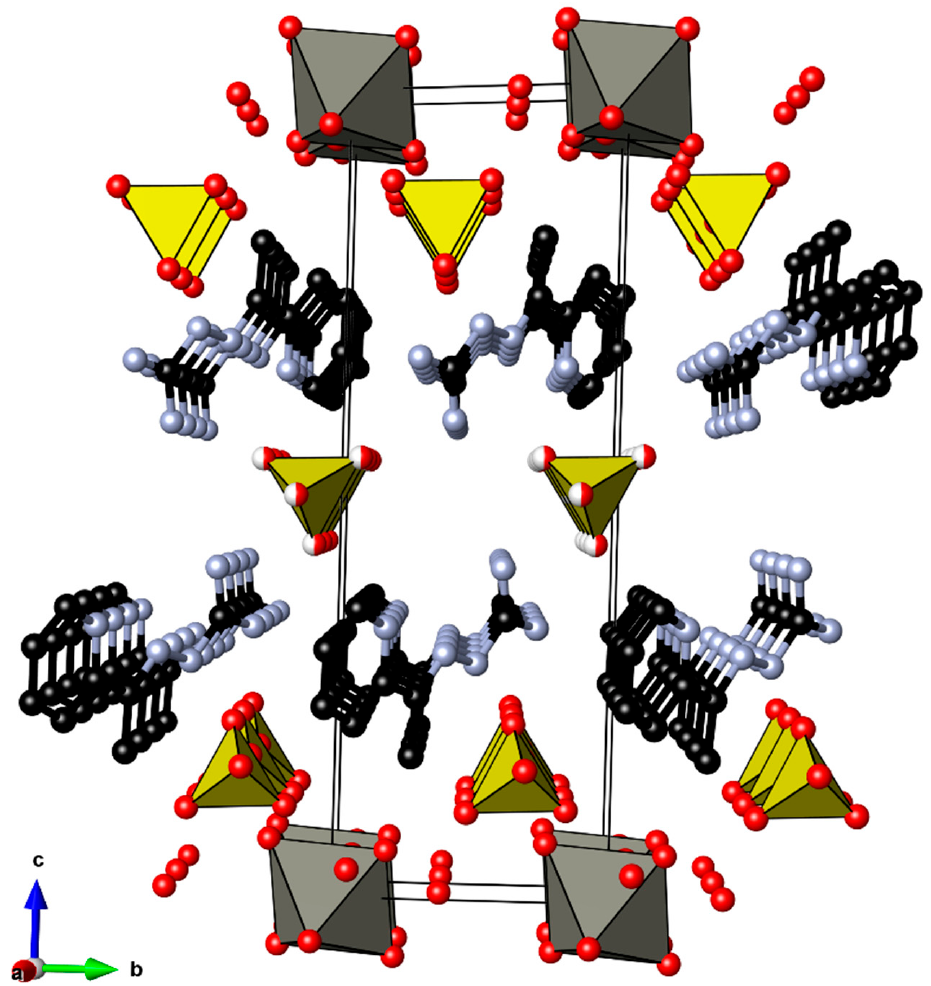
Figure 4. Perspective view of the crystal structure of Complex 1 perpendicular to the bc plane. Hydrogen atoms are omitted for the sake of clarity. Only one set of disordered sulfate ions at approximately z = 0.5 is shown.